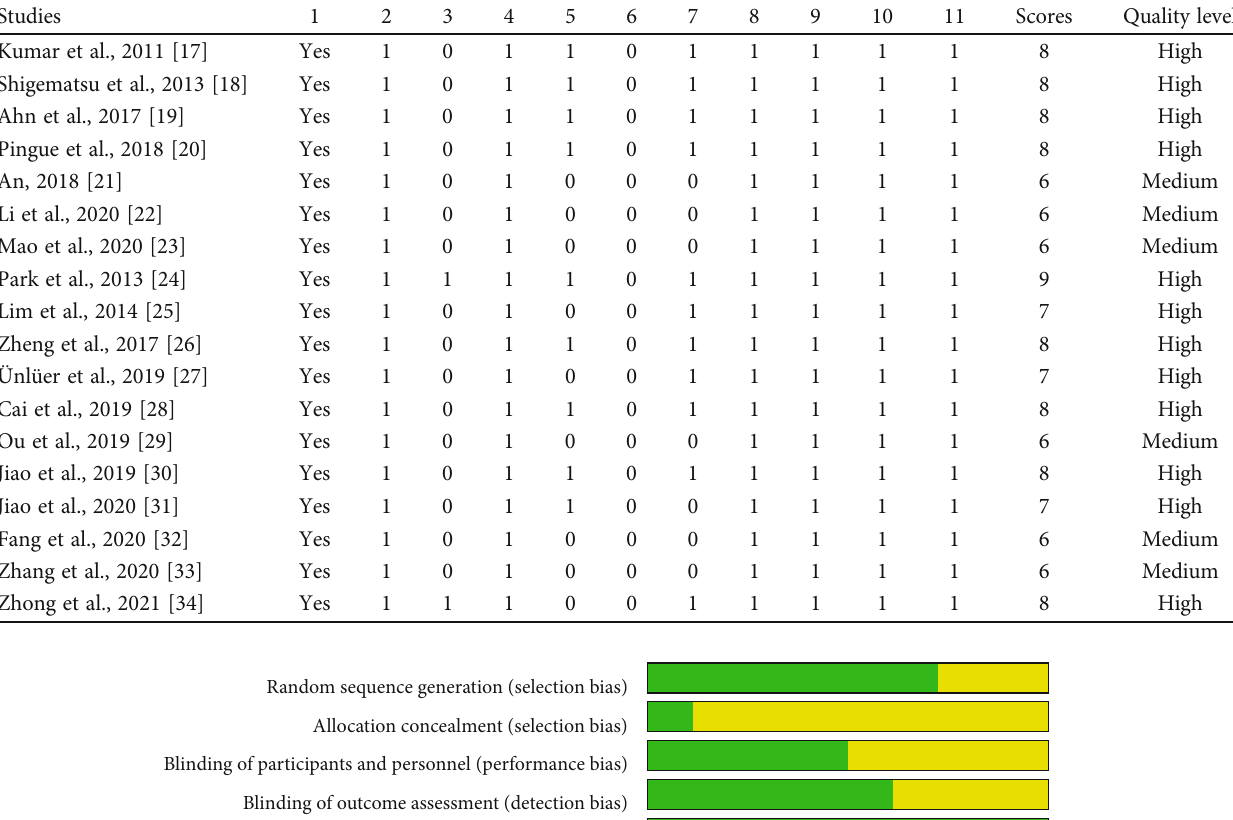
Table 2: PEDro scores of the included studies.